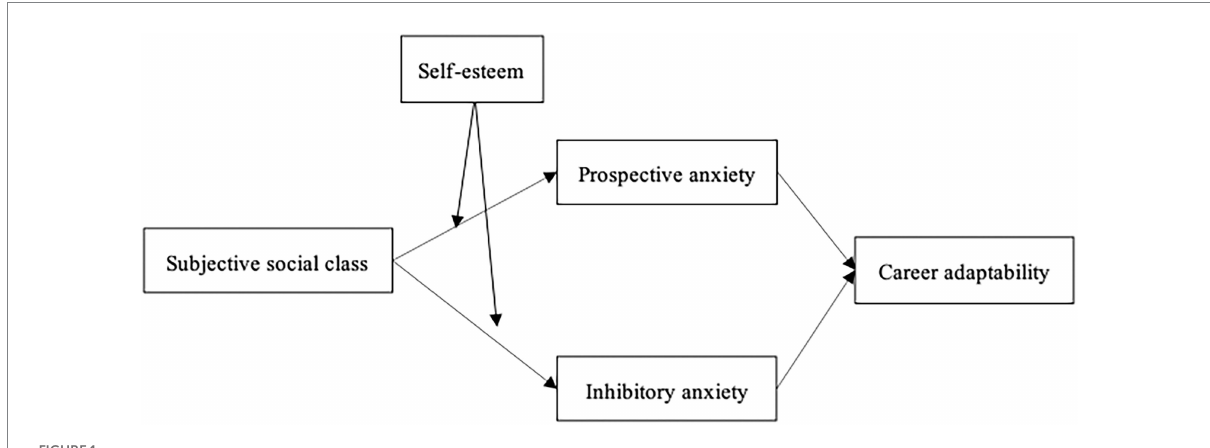
FIGURE 1 Research